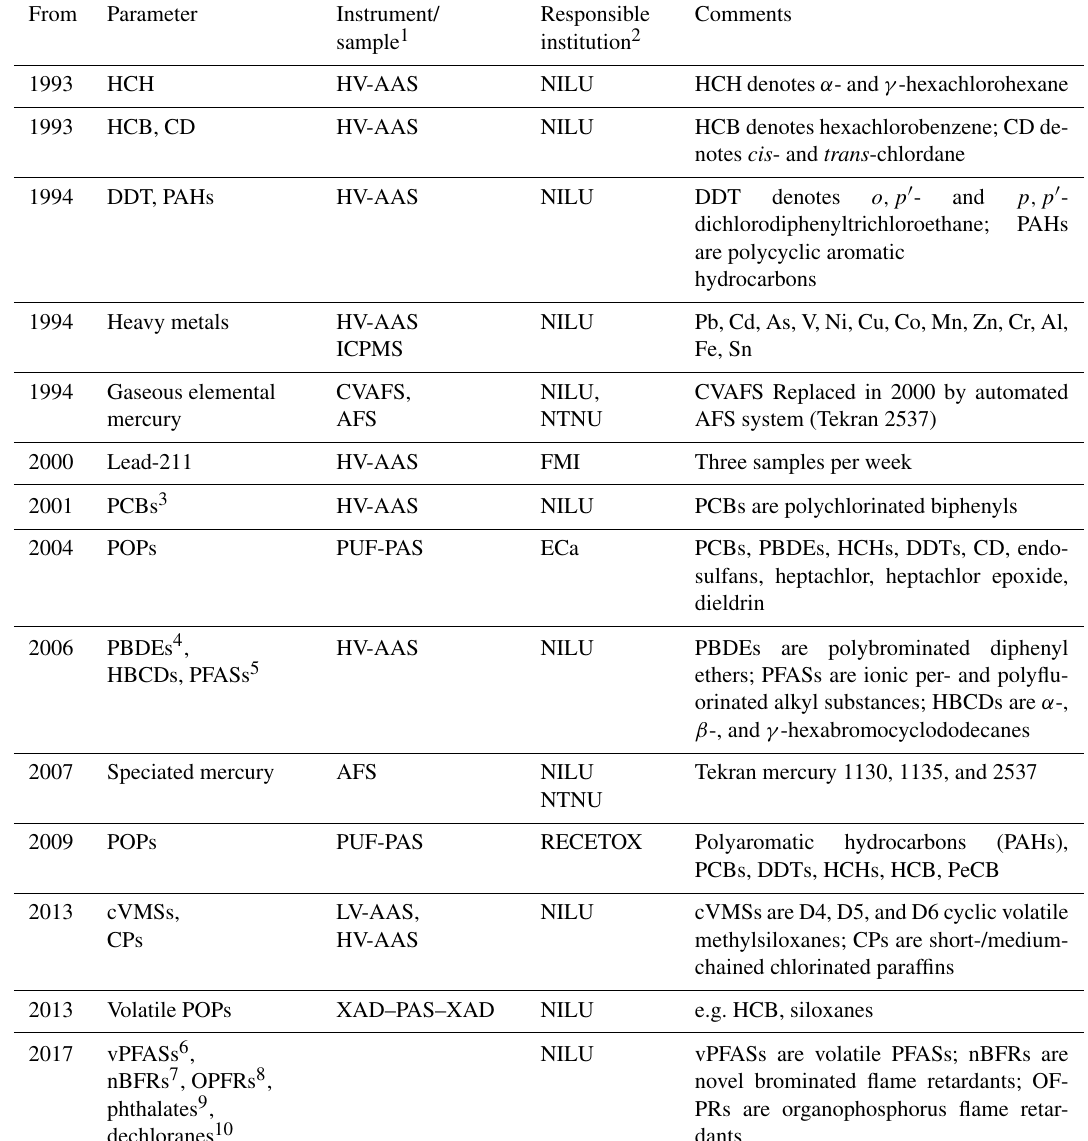
Table 4. Measurements of persistent organic pollutants (POPs) and other environmental contaminants at the Zeppelin Observatory listed chronologically by measurement starting year and responsible institutions. See table footnotes for lists of